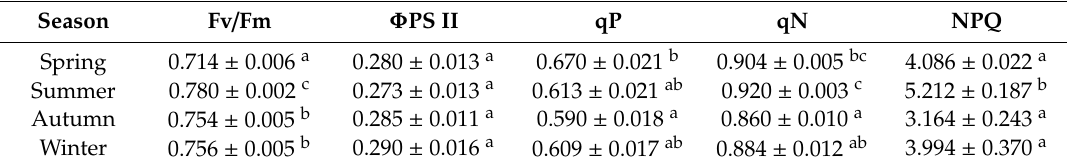
Table 2. Analysis of variance (ANOVA) results of chlorophyll a fluorescence parameter values (Fv / Fm, Φ PS II, qP, qN, NPQ) between slopes (NE and SW) with respect to di ff erent seasons (spring, summer, autumn, winter) in S. ruralis